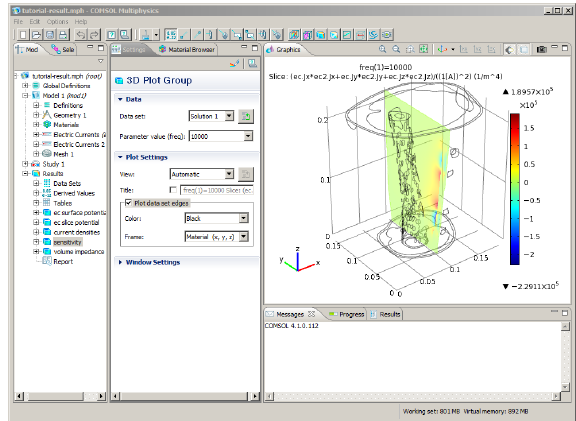
Fig. 8: A typical MPH window with a simulation result in the